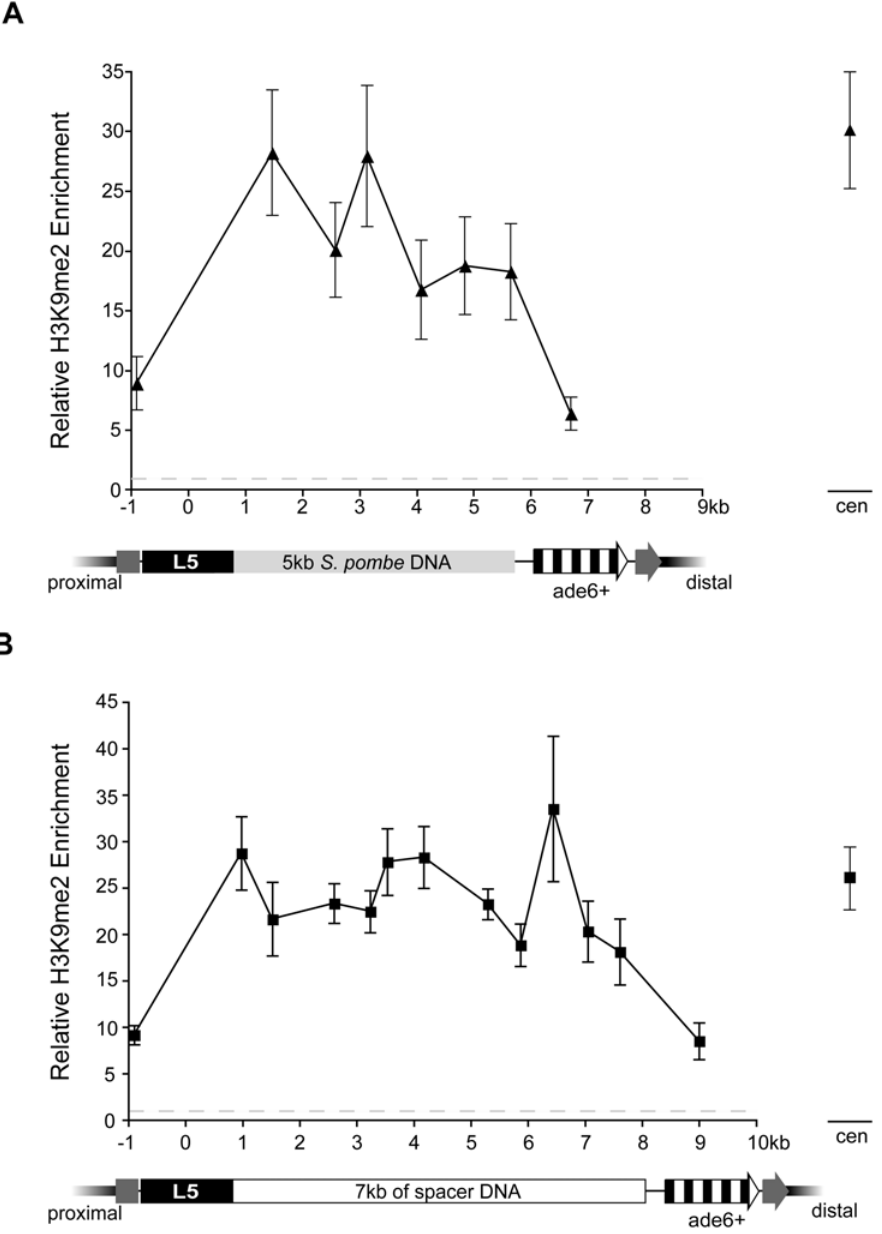
Figure 2. H3K9me2 is highly enriched over intergenic and spacer DNA fragments. H3K9me2 enrichment is plotted versus S. pombe intergenic DNA as shown in light grey (A) and DNA from the phage lambda as shown in white (B). The dark grey arrow represents the disrupted ura4 gene. The data points on the far right represent the level of H3K9me2 enrichment observed at the pericentromeric repeats in the respective strains, as internal controls.